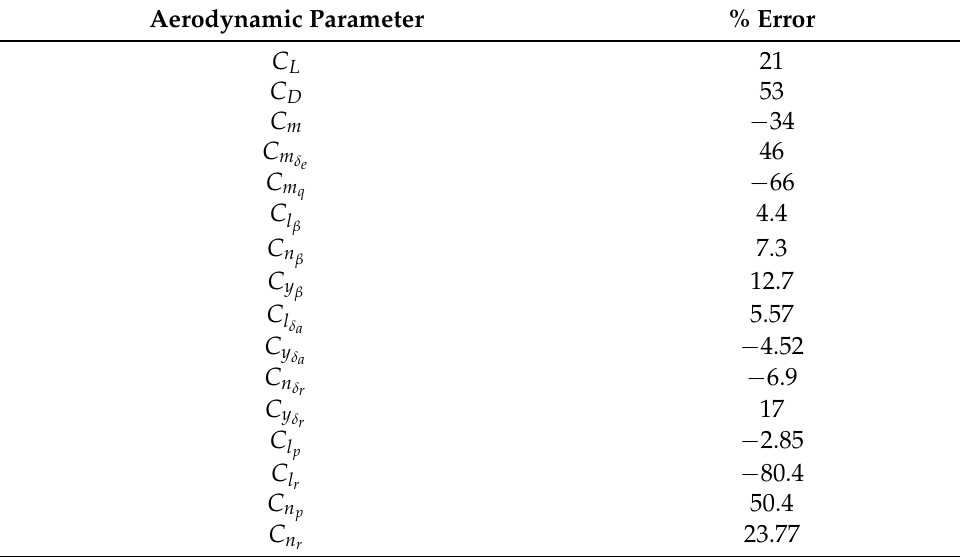
Table 5. Aerodynamic errors injected into the simulation model [35].